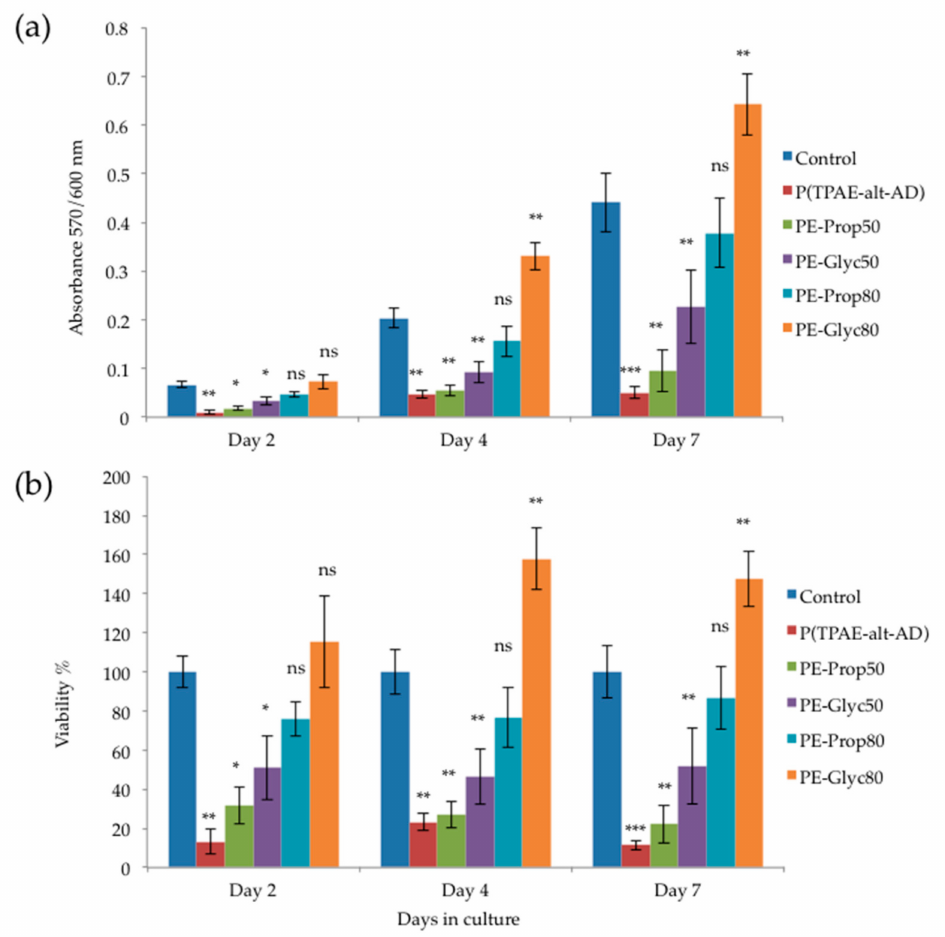
Figure 8. Cell viability and proliferation showing the absorbance at 570/600 nm ( a ) and the % viability ( b ) compared to the TCPS control on the functional polyester films on day 2, 4 and 7. A standard pattern in cell viability is present on day 2, which is also similar in days 4 and 7, except for the PE-Glyc80, which turns from statistically not significant, compared to the TCPS control on day 2, to statistically significant on days 4 and 7, clearly exceeding the TCPS control. Data are expressed as mean ± standard deviation. Asterisks denote statistical significance in viability for the functional polyesters compared to the TCPS control surface at each experimental time point (*: p < 0.05, **: p < 0.01, ***: p < 0.001, ns: not